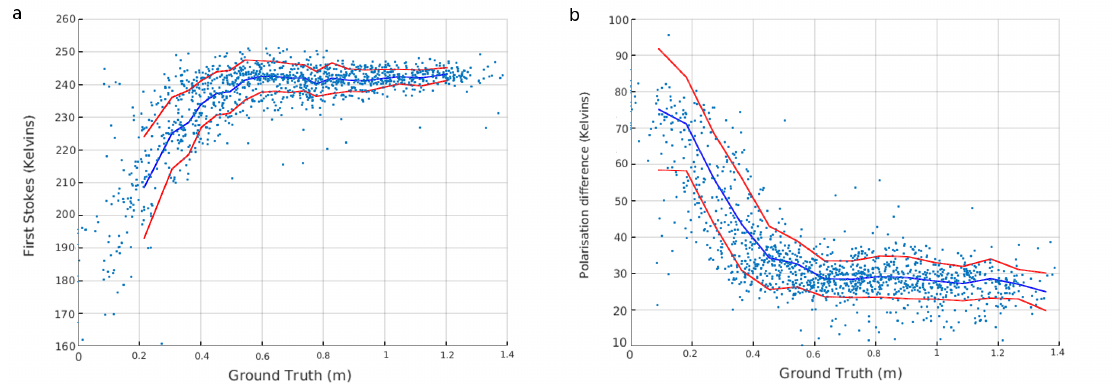
Figure 3. ( a ) Soil Moisture and Ocean Salinity (SMOS) First Stokes parameter calculated for 0–40 ◦ incidence angles against ULS derived SIT. ( b ) SMOS Polarization Difference (PD) at 50 ◦ incidence angle. The blue line represents the average and the red lines plus and minus one standard